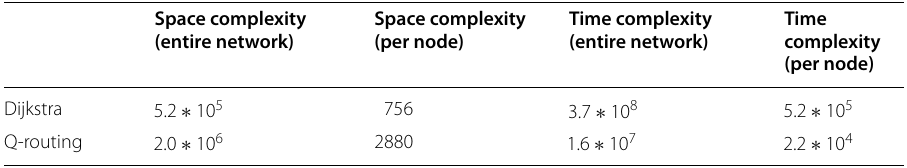
Table 3 Complexity analysis of Fig. 7 Space complexity (entire network)